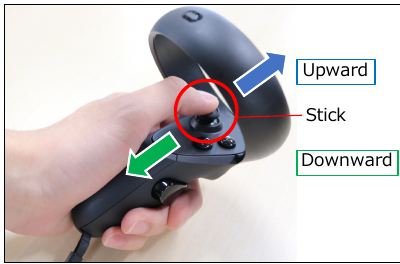
Figure 13. Operation with the handheld controller